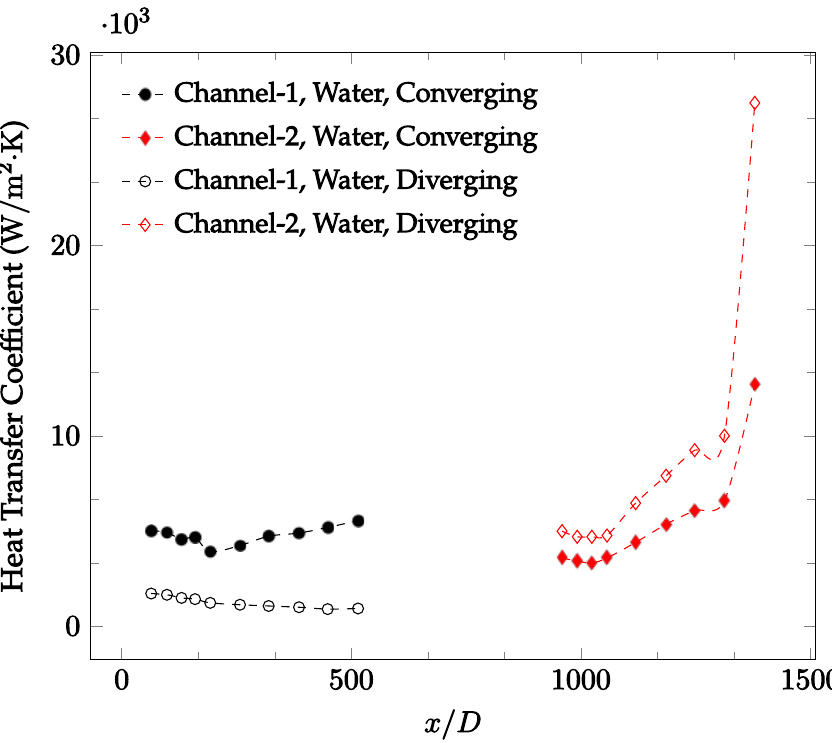
Figure 14. Change in convective heat transfer coefficient of deionized water as a function of dimensionless distance for a Reynolds number of 300. Converging and diverging nozzles are used as connectors.